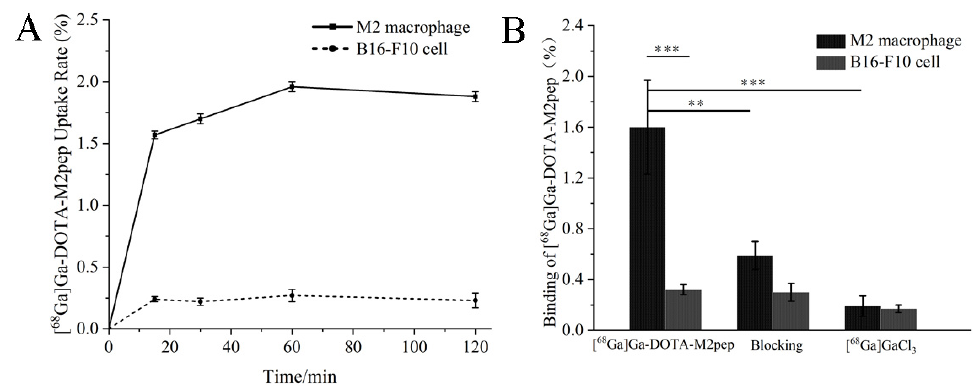
Figure 3. ( A ) Uptake of [ 68 Ga]Ga-DOTA-M2pep in macrophages and B16F10 cells. ( B ) Competitive binding assay of [ 68 Ga]Ga-DOTA-M2pep in macrophages and B16F10 cells (** p < 0.01, *** p < 0.001).